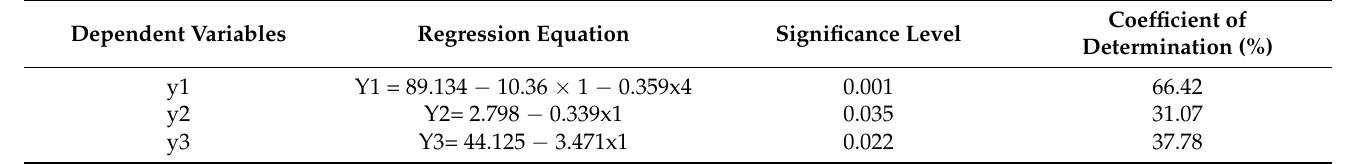
Coefficient of Determination (%)